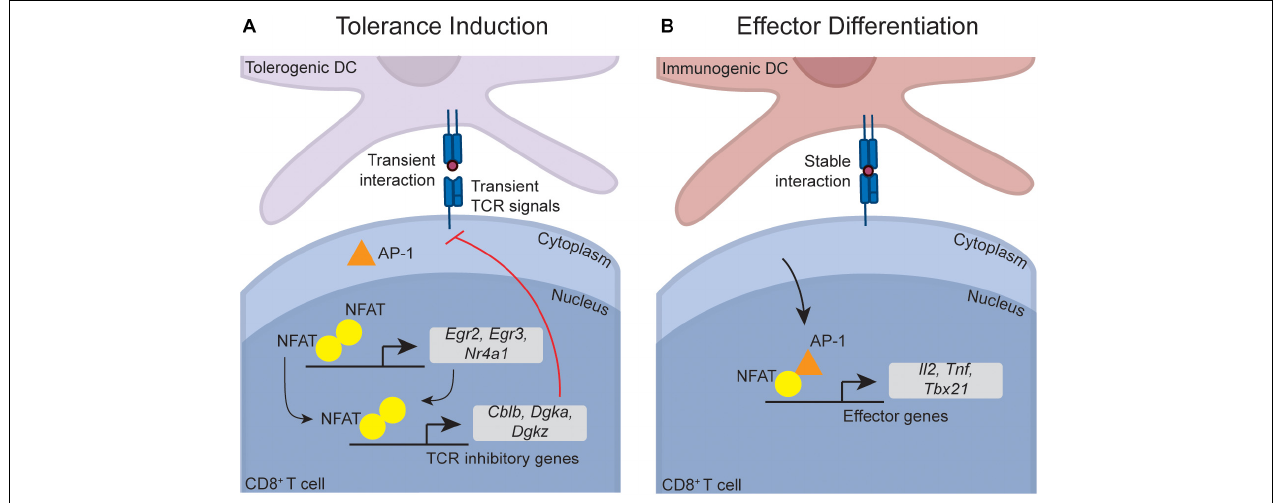
FIGURE 2 | Putative transcriptional pathways that program CD8 + T cell tolerance. Although not directly demonstrated within CD8 + T cells, data suggest that the NFAT-dependent transcriptional programs that induce CD4 + T cell anergy also operate during CD8 + T cell tolerance. During tolerance induction (A) , transient naïve CD8 + T cell interactions with DCs (which can occur due to PD-1 and CTLA-4 signaling) lead to an accumulation of NFAT in the nucleus in the absence of AP-1. This is because AP-1 is rapidly exported from the nucleus upon antigen withdrawal, while NFAT is slowly exported, meaning that transient interactions lead to preferential nuclear NFAT accumulation. In the absence of AP-1, NFAT forms low affinity homodimers that induce transcription factors such as Egr2 , Egr3, and Nr4a1 (also called Nur77). These transcription factors, in combination with NFAT, induce a range of factors that directly inhibit TCR signaling (such as Cblb , Dgka, and Dgkz ), thereby enforcing anergy. During effector differentiation (B) , stable DC-T cell interactions enable sustained TCR signaling, leading to accumulation of both AP-1 and NFAT within the nucleus. NFAT-AP-1 complexes are higher affinity than NFAT homodimers, meaning that in the presence of AP-1, NFAT-AP-1 complexes preferentially form. When complexed with AP-1, NFAT preferentially induces effector genes such as the cytokines Il2 and Tnf , and Tbx21 (encoding TBET), which in turn induces Ifng